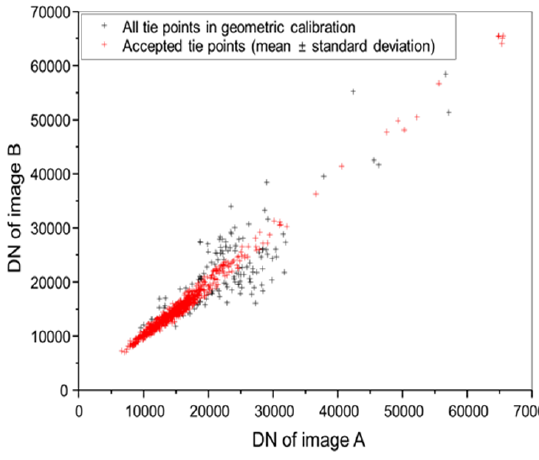
Figure 9. Natural color composite of reflectance map by (a) RCOP and (b) validation